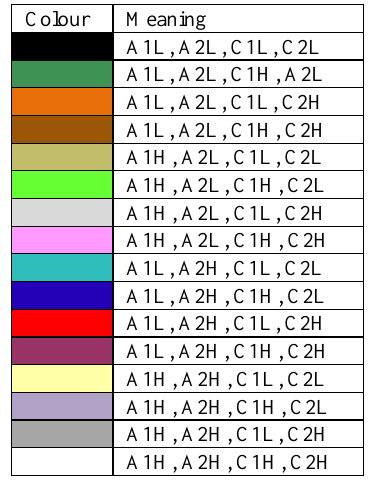
Table 1. Colour code for Figure